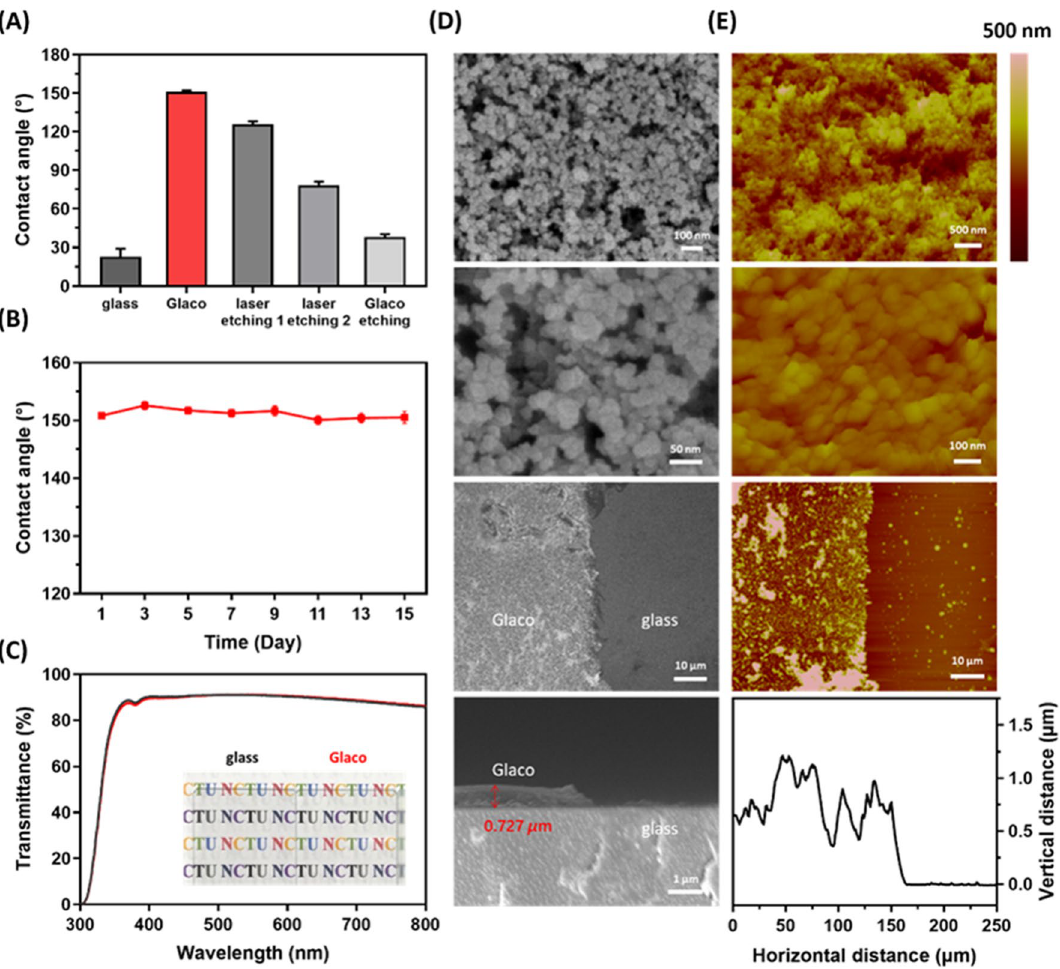
Figure 1. Characterizations of the superhydrophobic film. ( A ) The contact angle of the bare glass, Glaco- modified coating on the glass and the glass with laser patterns. ( B ) Stability of the superhydrophobic film. ( C ) Investigation of the transmittance of glass and Glaco-modified film. ( D ) SEM images (top-view, side-view) of Glaco-modified surface, including different zooms and thickness of ∼ 0.7 µm. ( E ) Corresponding profile of AFM scan showing the size and structure of the Glaco nanoparticles and